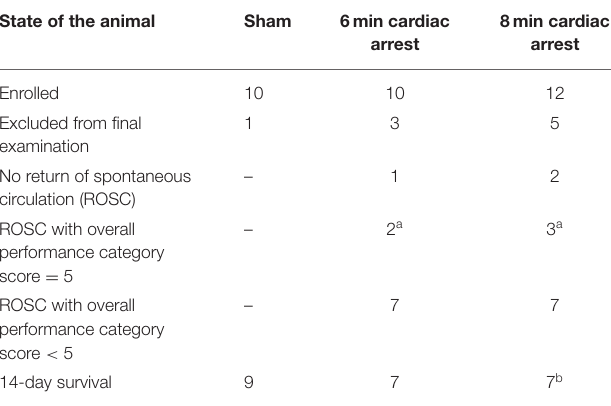
TABLE 1 | Overview of animals enrolled in the study ( n = 32). TABLE 2 | Results of repetitive neurological scoring of experimental